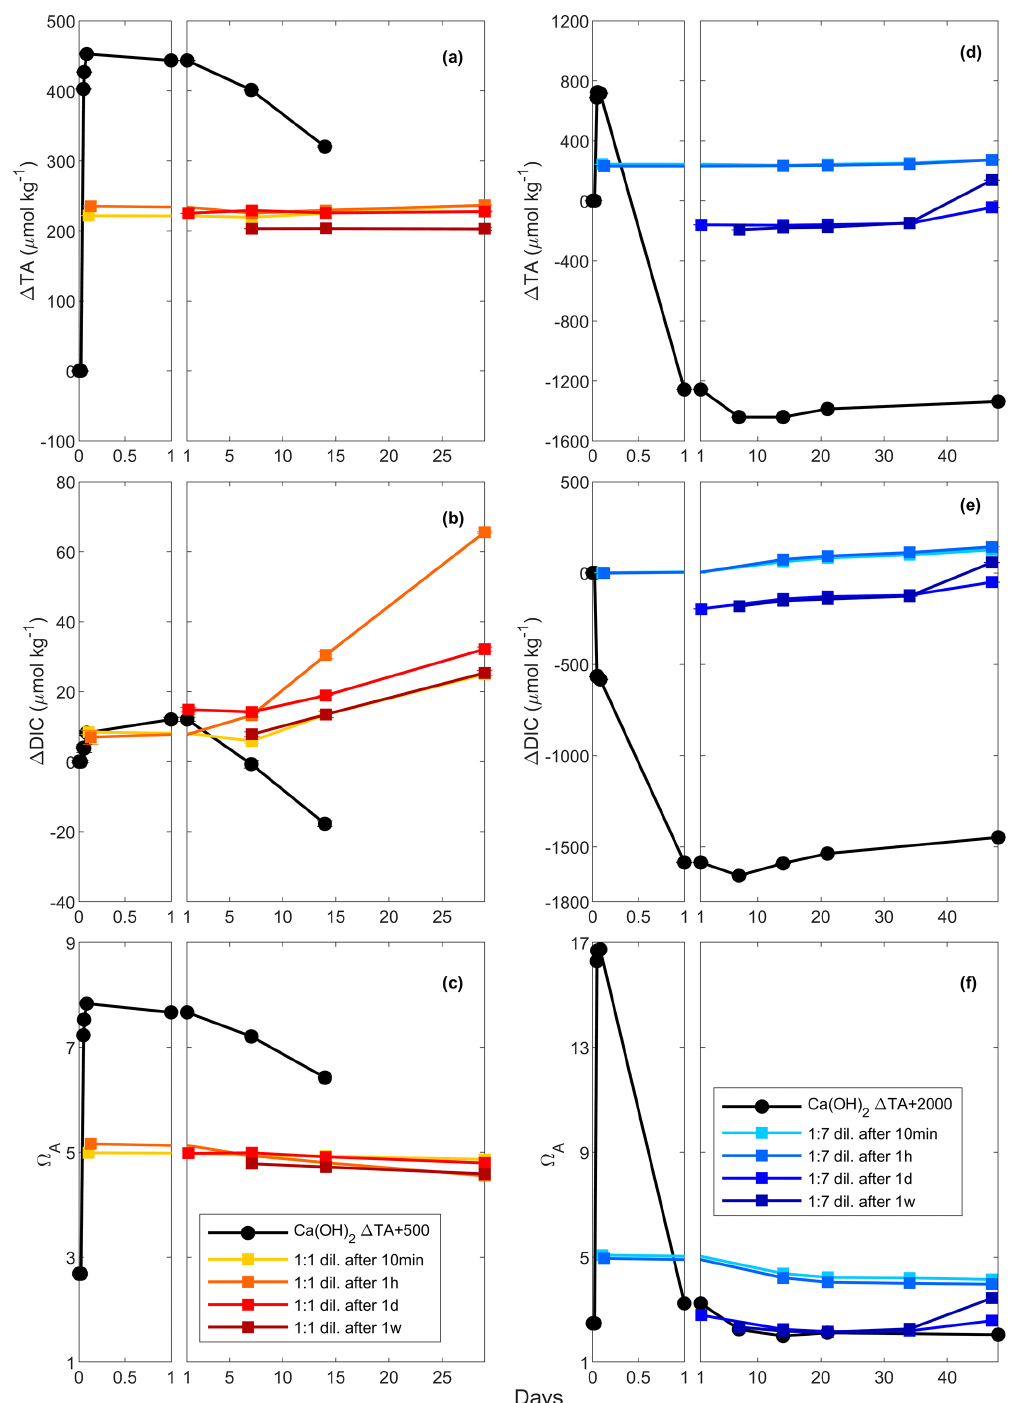
Figure 4. Changes in TA ( a and d ), DIC ( b and e ) and (cid:127) A ( c and f ) following a TA addition of 500 and 2000µmolkg − 1 , respectively, by Ca(OH) 2 (black line), as well as following a 1 : 1 dilution for the 500µmolkg − 1 TA addition (red and yellow lines) and a 1 : 7 dilution for the 2000µmolkg − 1 TA addition (blue lines). The dilutions were performed after 10min, 1h, 1d and 1 week, and earlier dilutions are represented by lighter